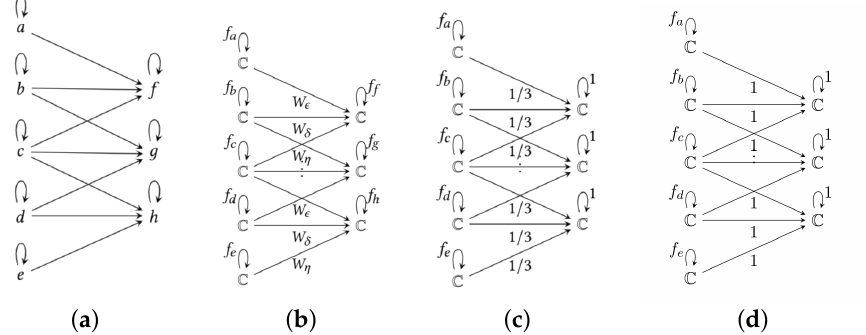
Figure 5. ( a ) Combinatorial architecture of a convolutional and a pooling layer. ( b ) Weight and activation architecture of a convolutional layer. ( c ) Weight and activation architecture of an average pooling layer. ( d ) Weight and activation architecture of a max-pooling